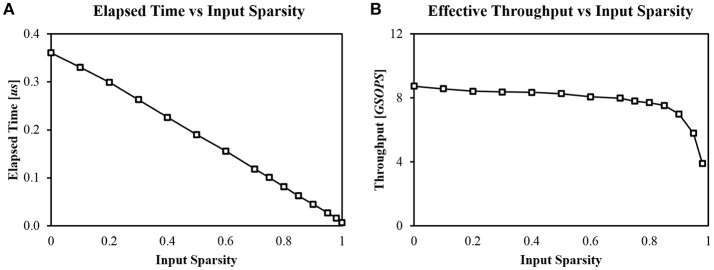
(A) Computation time with different input sparsities (P = 128, 1024 × 256 random network) and (B) Corresponding effective throughput of the system.